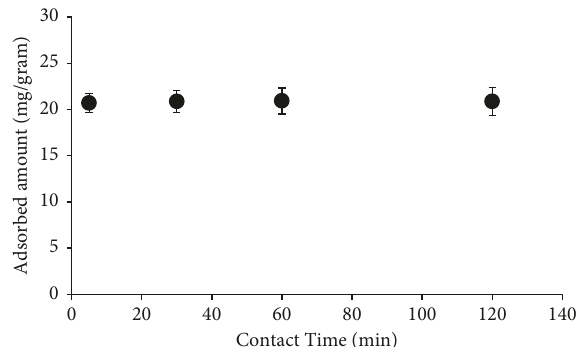
Figure 1: The time course of copper(II) adsorption to the biofilm. The experiment was repeated three times, independently (average values are shown). Bars represent the standard error. Figure 2: The effectiveness of copper(II) Cu adsorption to the